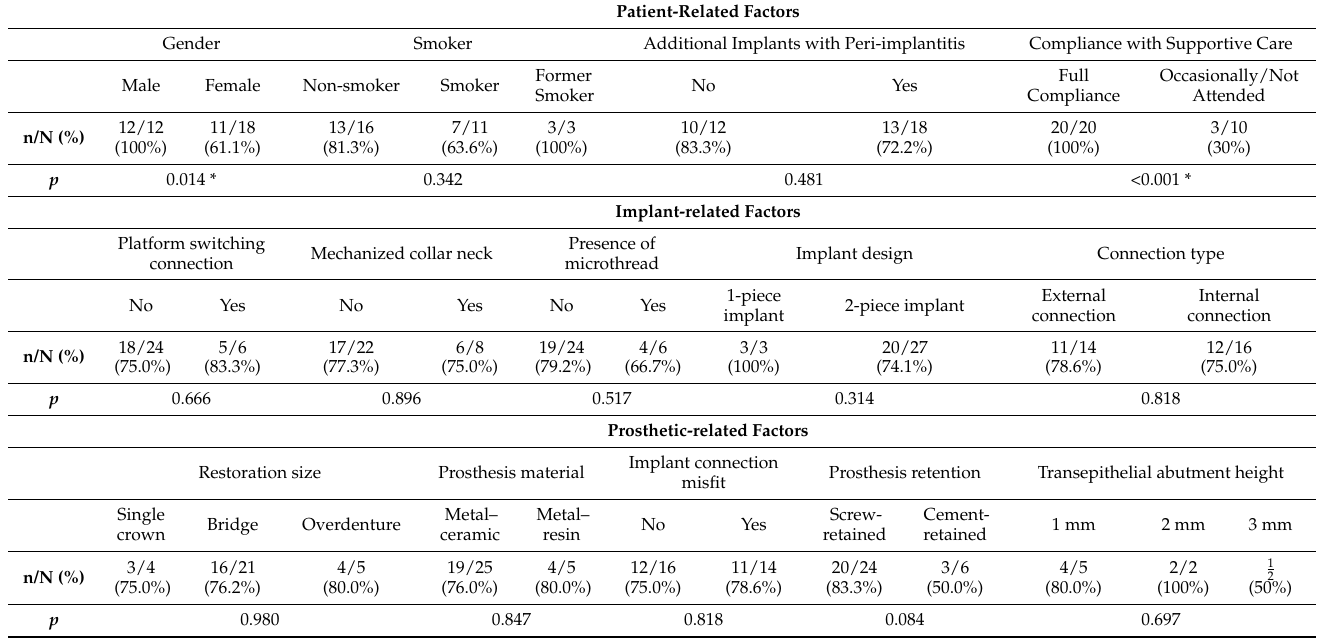
Table 3. Evaluation of different patient-, implant-, and prosthetic-related factors and disease reso- lution, expressed as absolute number of cases (n) out of total cases (N) and percentage of cases (%) where disease resolution was achieved after treatment in each